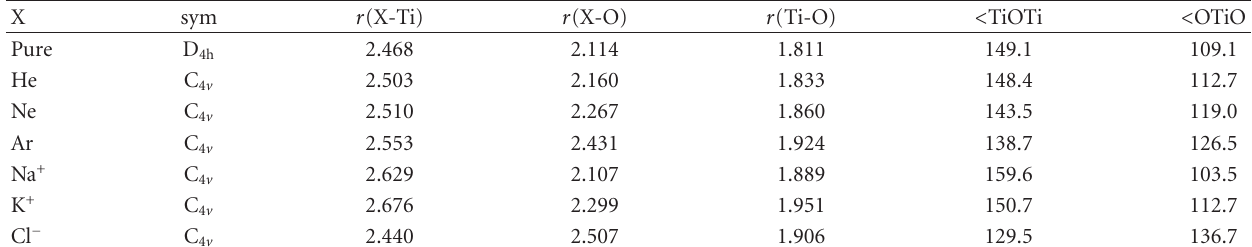
Table 3: Some geometrical parameters (˚A and degrees) of the D 4 face where the insertion takes place in the transition structure connecting X(Ti-T8) and X@(Ti-T8); X = He, Ne, Ar, Na + , K + , Cl − at the B3LYP/6-311+G(d) level.